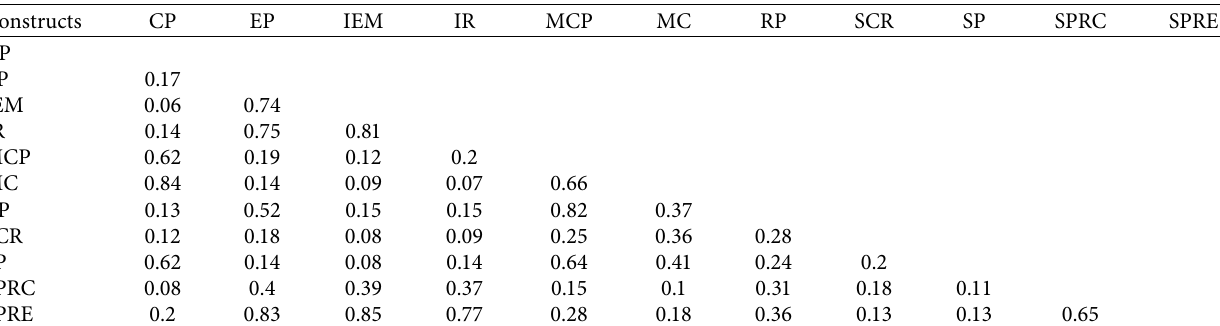
Table 9: Discriminant validity analysis using (HTMT